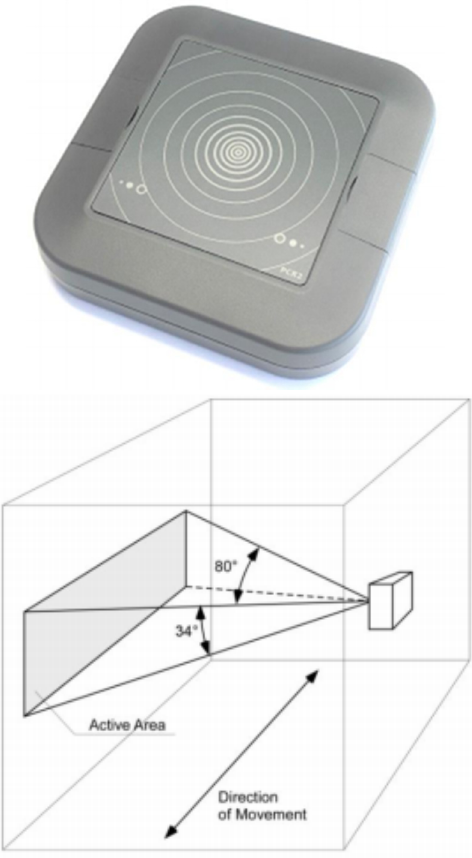
Figure 3. Parametric PCR2 Radar Sensor and FoV for Radar Sensor (PCR2 Equipment Manual).